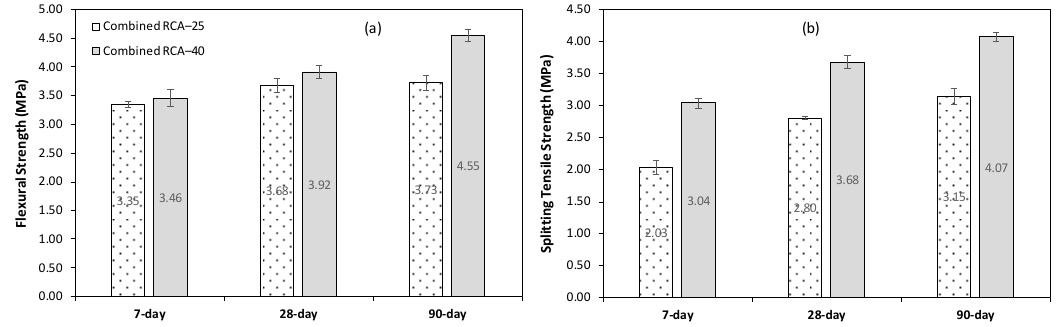
Figure 3. ( a ) Flexural strength and ( b ) Splitting tensile strength development of Combined RCA Figure3. ( a )Flexuralstrengthand( b concrete.